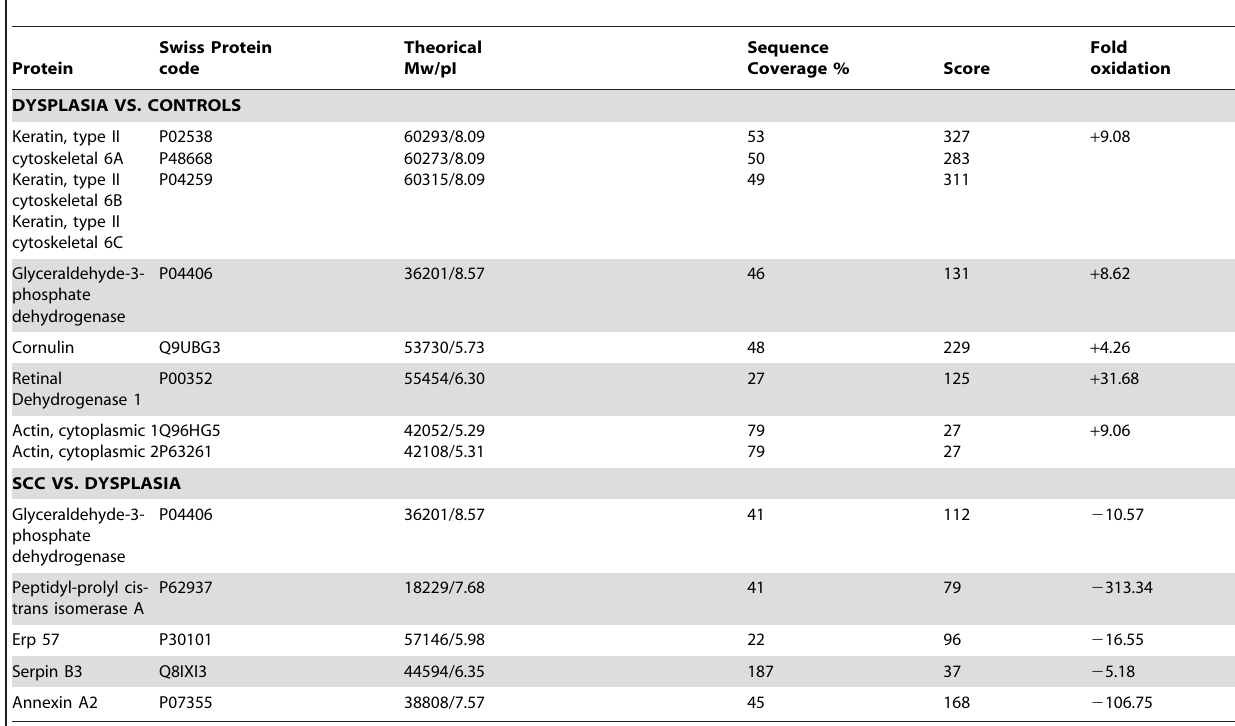
Table 3. List of oxidized proteins successfully identified by mass spectrometry along with the peptide hits, sequence coverage, Mw and pI values and the increase/decrease of specific carbonyl levels, indexed as fold oxidation.